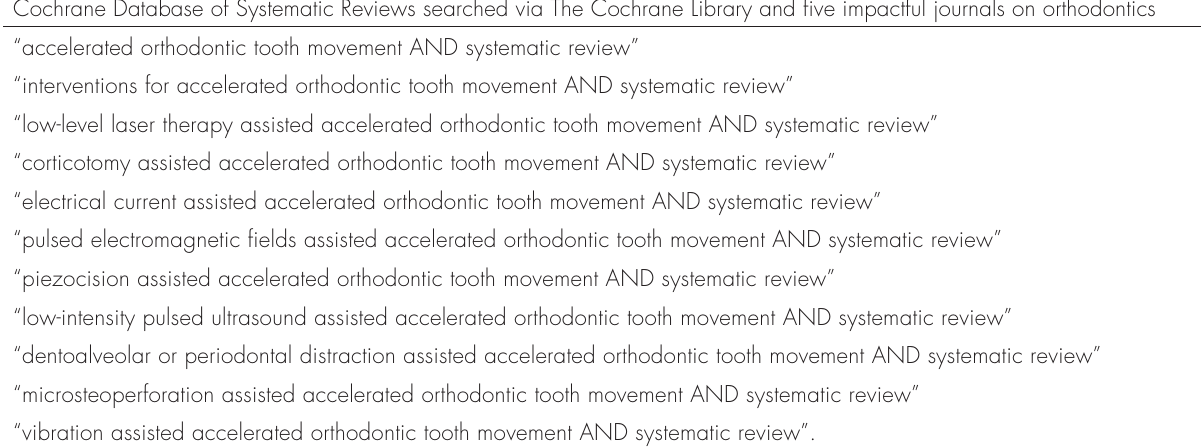
Table II. Search terminologies and phrases. Cochrane Database of Systematic Reviews searched via The Cochrane Library and five impactful journals on orthodontics “accelerated orthodontic tooth movement AND systematic review” “interventions for accelerated orthodontic tooth movement AND systematic